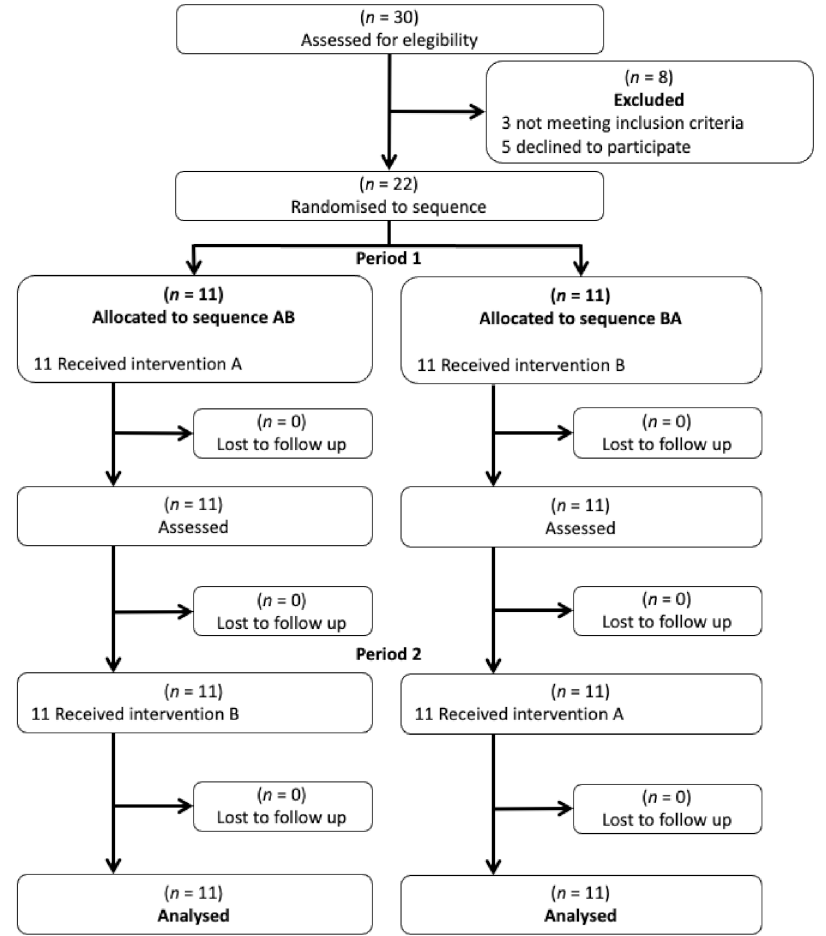
Figure 1. Flowchart according to CONSORT statement for the report of randomized